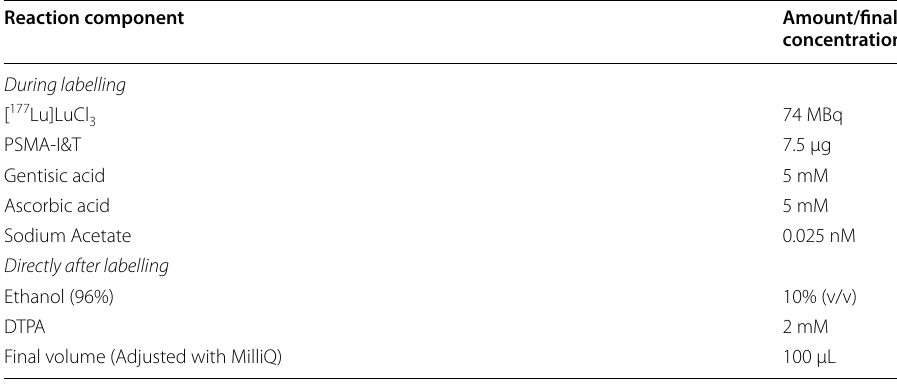
Table 1 Reaction conditions of standardized labelling for qualification of equipment Reaction